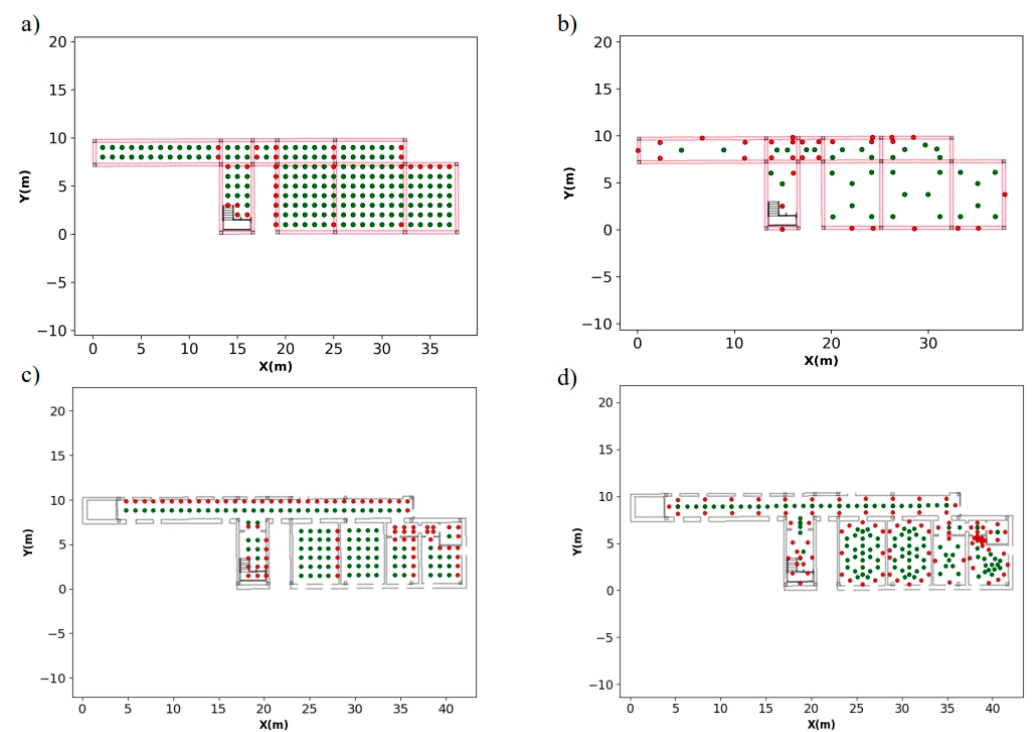
Figure 14. Candidate positions generated by both discretization methods in case study 1: ( a ) grid- based method in structural phase, ( b ) triangulation-based method in structural phase, ( c ) grid-based method with rooms and d) triangulation-based method with rooms. Horizontal and vertical elements are displayed in magenta and black respectively. Green points represent position reachable by robotic system, unreachable positions are depicted in red.